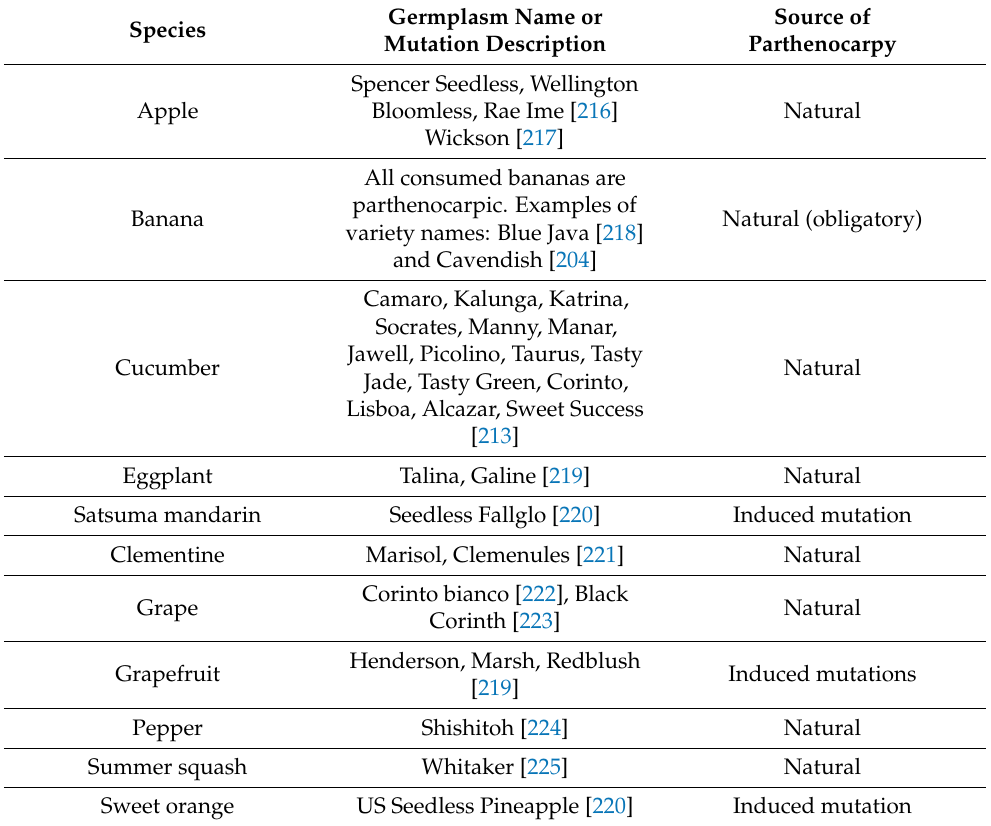
Table 1. List of plant species with parthenocarpic fruit development currently on the market. Germplasm Name or Source of Species Mutation Description Parthenocarpy Spencer Seedless, Wellington Apple Bloomless, Rae Ime [216] Natural Wickson [217] All consumed bananas are parthenocarpic. Examples of Banana Natural (obligatory) variety names: Blue Java [218] and Cavendish [204] Camaro, Kalunga, Katrina, Socrates, Manny, Manar, Jawell, Picolino, Taurus, Tasty Cucumber Natural Jade, Tasty Green, Corinto, Lisboa, Alcazar, Sweet Success [213] Eggplant Talina, Galine [219] Natural Satsuma mandarin Seedless Fallglo [220] Induced mutation Clementine Marisol, Clemenules [221] Natural Corinto bianco [222], Black Natural Corinth [223] Henderson, Marsh, Redblush Grapefruit Induced mutations [219] Pepper Shishitoh [224] Natural Summer squash Whitaker [225] Natural Sweet orange Induced